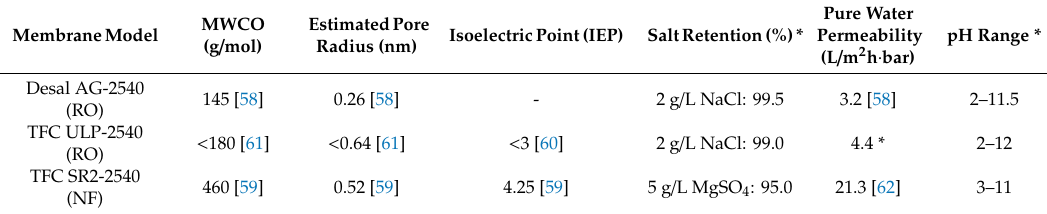
Table 2. Characteristics of the selected nanofiltration / reverse osmosis (NF / RO) membranes.